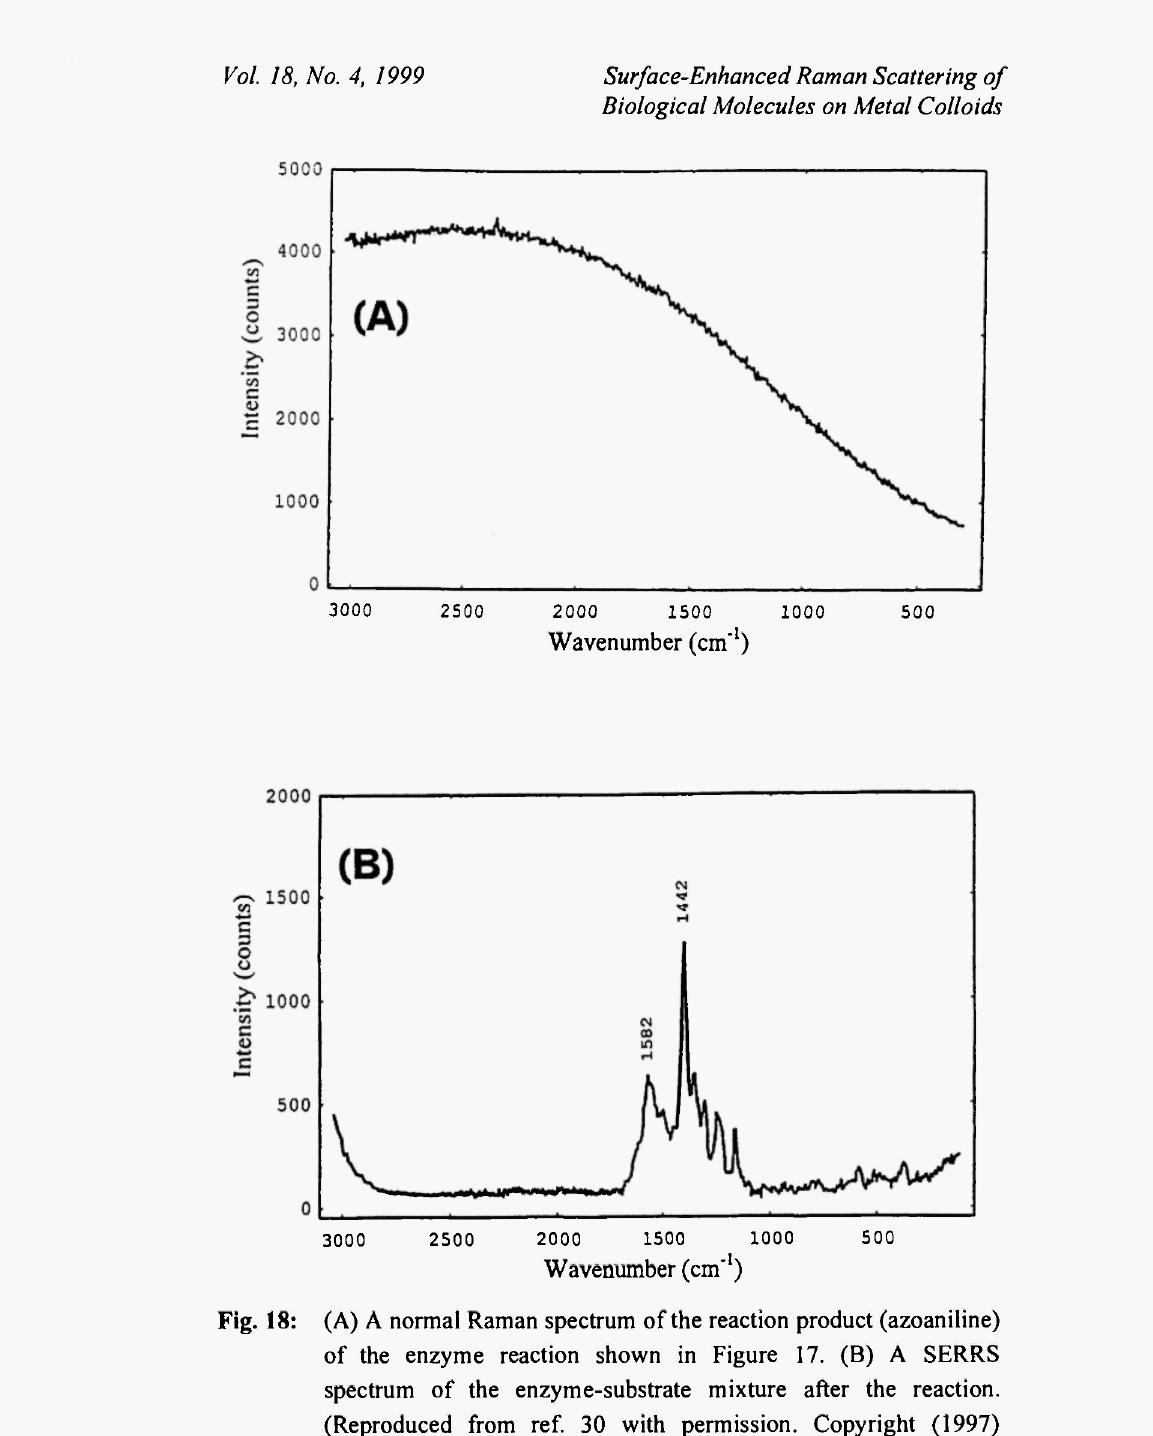
Fig. 18: (A) A normal Raman spectrum of the reaction product (azoaniline) of the enzyme reaction shown in Figure 17. (B) A SERRS spectrum of the enzyme-substrate mixture after the reaction. (Reproduced from ref. 30 with permission. Copyright (1997) American Chemical Society).